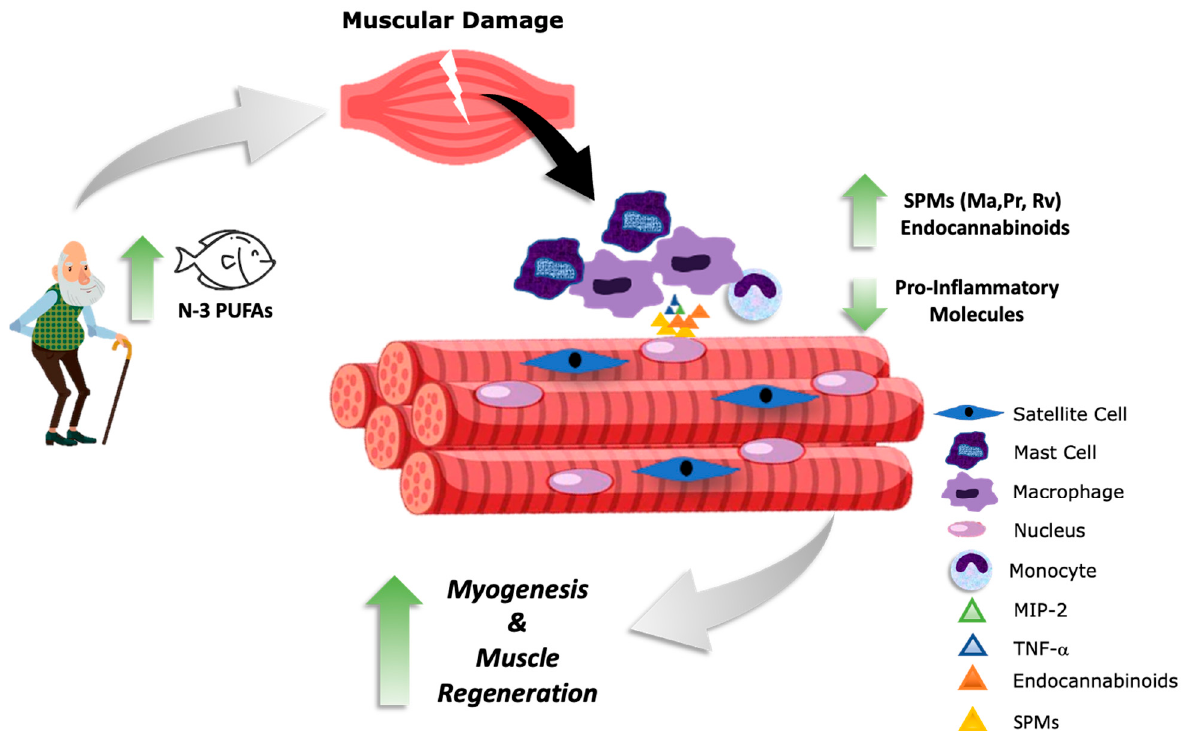
Figure 3. Potential benefits of the omega-3 (n-3) polyunsaturated fatty acid (PUFA) lipid mediators after muscular damage. N-3 PUFA consumption leads to increased synthesis of endocannabinoids and specialized proresolving mediators (SPMs) such as resolvins (Rv), maresins (Ma), and protectins (Pr), leading to a decrease in the production of proinflammatory molecules. These effects may accelerate inflammation resolution, improving myogenesis and muscle regeneration. TNF- α : tumor necrosis factor alpha; MIP-2: macrophage inflammatory protein-2. The Figure was partly